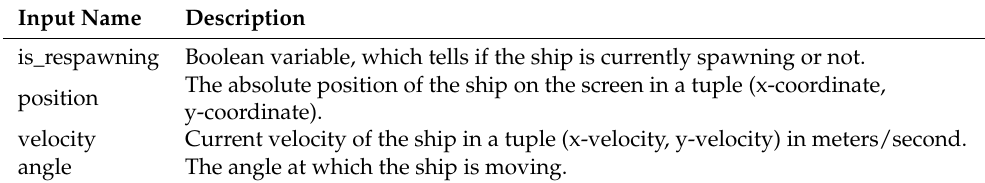
Table 2. Available inputs for the ship.